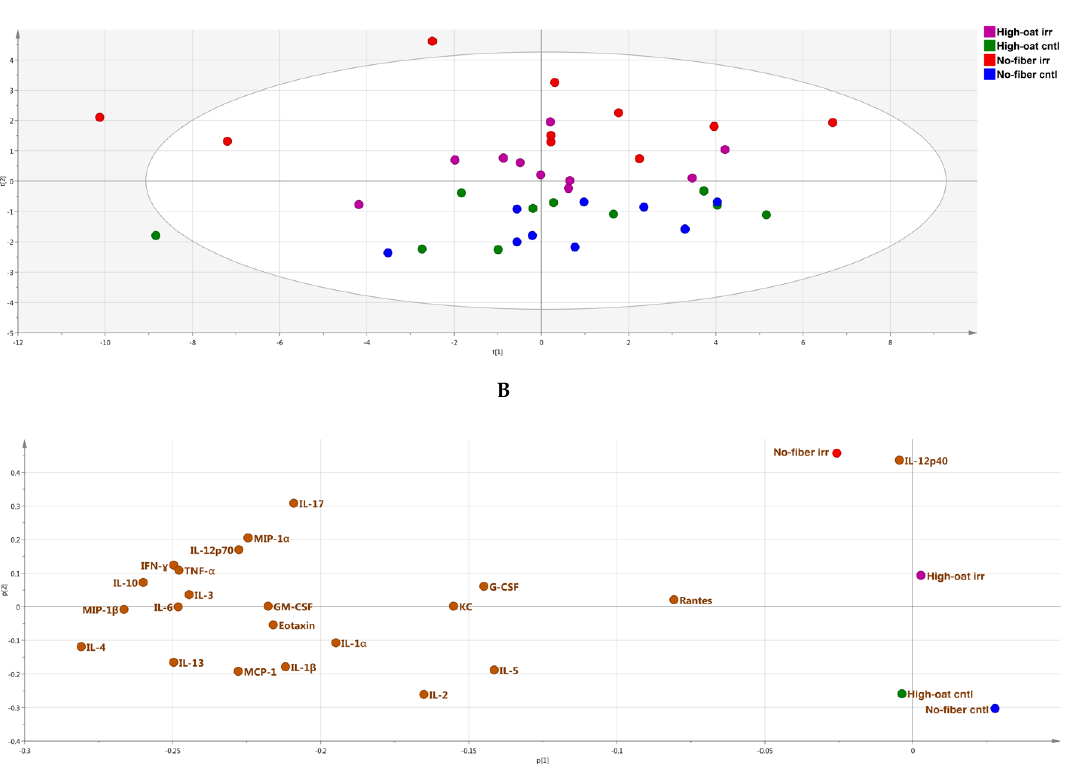
Figure 5. PCA analysis of serum cytokines and chemokines levels in mice at 6 weeks post-irradiation. ( A ) PCA score scatter plot of cytokine profiles, showing discrimination between the groups. ( B ) PCA loading scatter plot showing the associations between the cytokines and different groups.